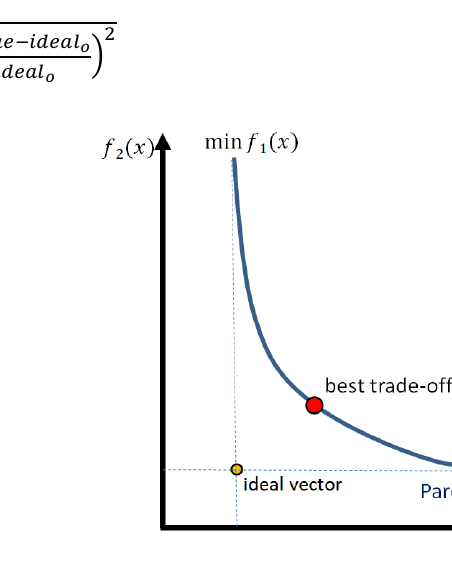
Figure 2. Representation of the ideal solution or vector of the instance and the best compromising solution achieved by each